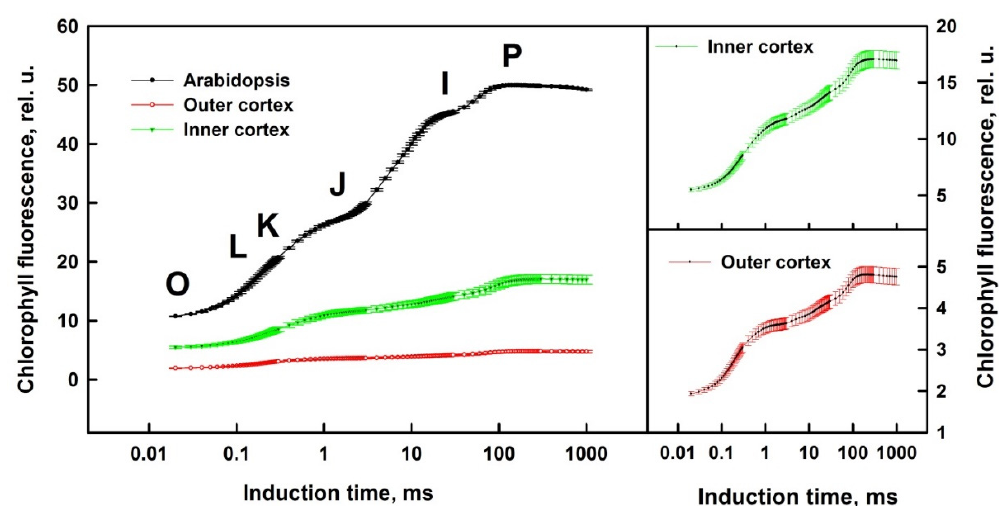
Figure 2. Induction curves recorded in inner and outer cortices of the Smicronix galls and in the leaves of reference photosynthetic plant A. thaliana (averaged over seven repetitions). The prompt fluorescence of the two cortices of the galls was measured in about 2 mm thick slices. The IC for the inner cortex only is presented above on the right, and for the outer cortex only, below on the right. The ranges of the relative units on the y-axes of the two smaller graphics on the right are different so that the slopes can be visible.